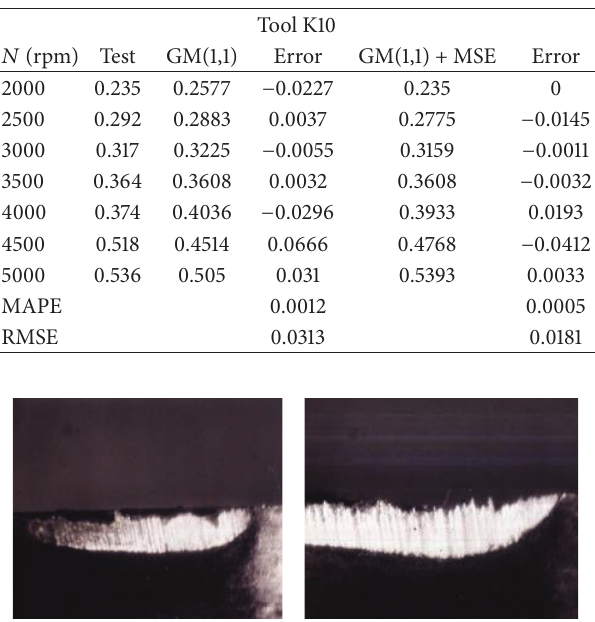
Figure 6: Tool wear of coated TiN tool ( 𝑁 = 2000 ∼ 𝑁 = 5000 rpm).